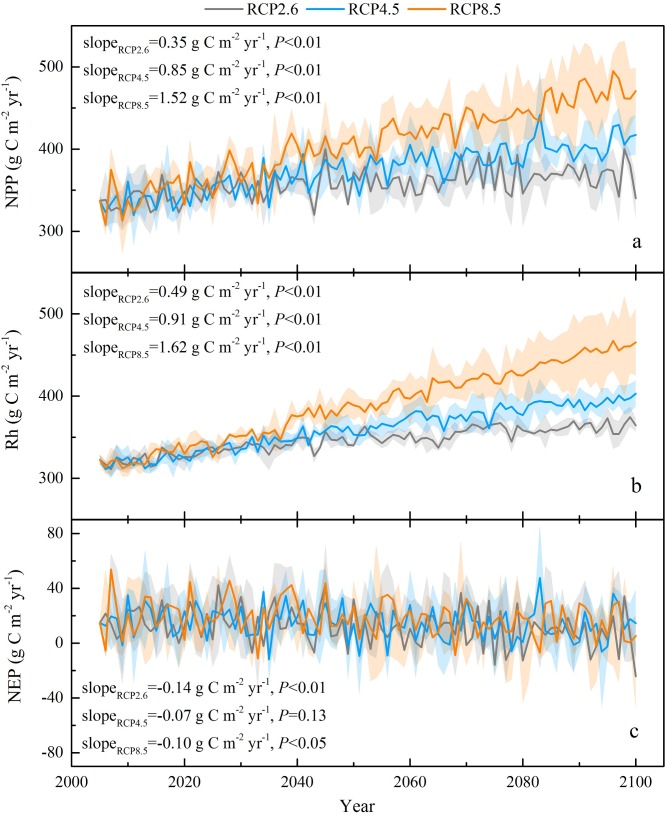
Temporal dynamics of simulated NPP (a), Rh (b), and NEP (c) in the Tibetan Plateau grassland from 2006 to 2100. Solid lines are the three climate models means under different RCP scenarios, and the shading area denotes one standard deviation.